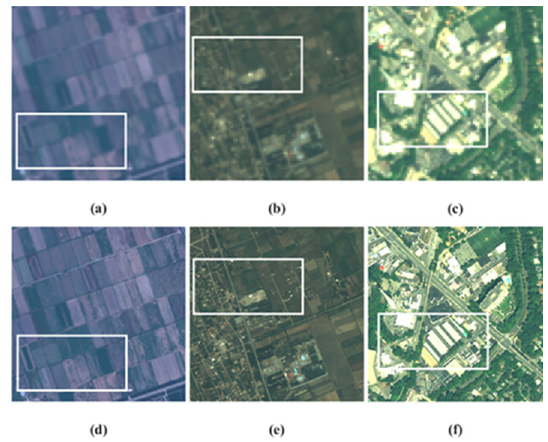
Figure 7. RGB composite of datasets in Group-2 used for the experimental evaluation. ( a ), ( b ) and ( c ) GeoEye-1, Ikonos, and WorldView resampled images with LSR of 7.36 m, 13.12 m, and 7.36 m, respectively. ( d ), ( e ), and ( f ) are the corresponding original images with HSR of 1.84 m, 3.28 m, and 7.36 m, respectively. White rectangles denote areas used for visual